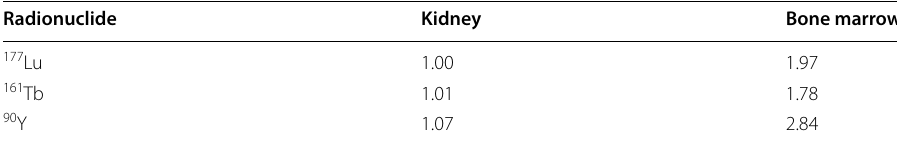
Table 2 The fraction between rudimentary self-irradiation S-values (calculated by assuming an absorbed fraction equal to 1 and the total energy emission per decay) and model-based self- irradiation S-values from either a kidney model (OLINDA version 2.1) or the bone marrow model used in this study [22]. A fraction differing from 1 emphasizes the complexity of the dosimetry model compared to the rudimentary approach